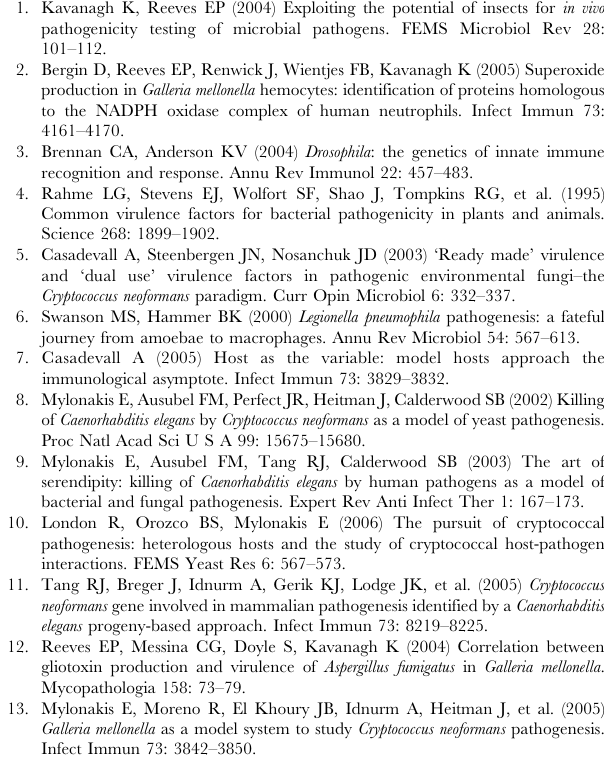
Figure S3 Size distribution of color mutants and their corresponding wild types at different stages of the germination process. Conidia were cultured in YPD media at 37 u C with shaking for the indicated time, fixed, and then photographed. Cell size was determined by measuring the cell diameter from digital images. The image on the top shows the germination process: resting/dormant conidia (a), swollen conidia (b, c), pear shaped conidia (d), germ tubes (e), and hyphae (f). The bottom graph shows the conidia size distribution of each strain at 0, 3, 5, and 7 hours. Found at: doi:10.1371/journal.pone.0004224.s003 (1.00 MB TIF) Table S1 Metalloproteinase activity in color mutant and wild type